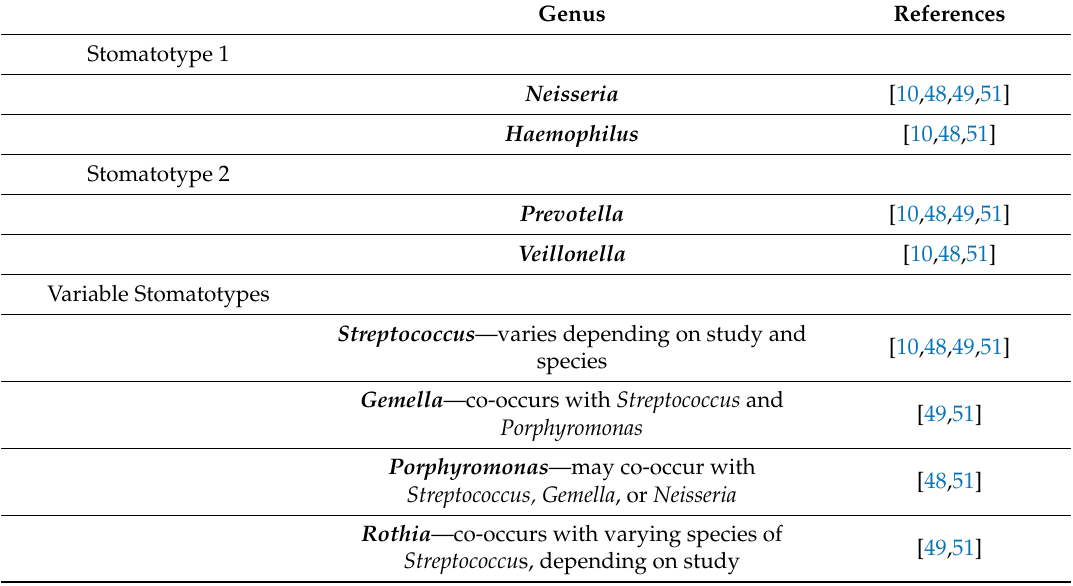
Table 3. Consensus stomatotype-driving genera. Genera that have been shown in the literature to strongly drive the distinction between samples of oral microbiome datasets by di ff erences in their abundances. The stomatotype numbers are arbitrarily assigned. The genera are listed in the second column, along with notes on associations between the organisms where relevant. The third column contains the references to the literature, which shows these stomatotype